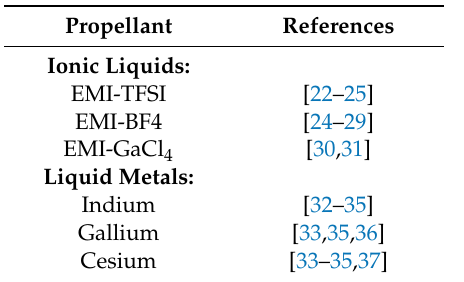
Table 1. Microfluidic properties references for propellants in the ESPET